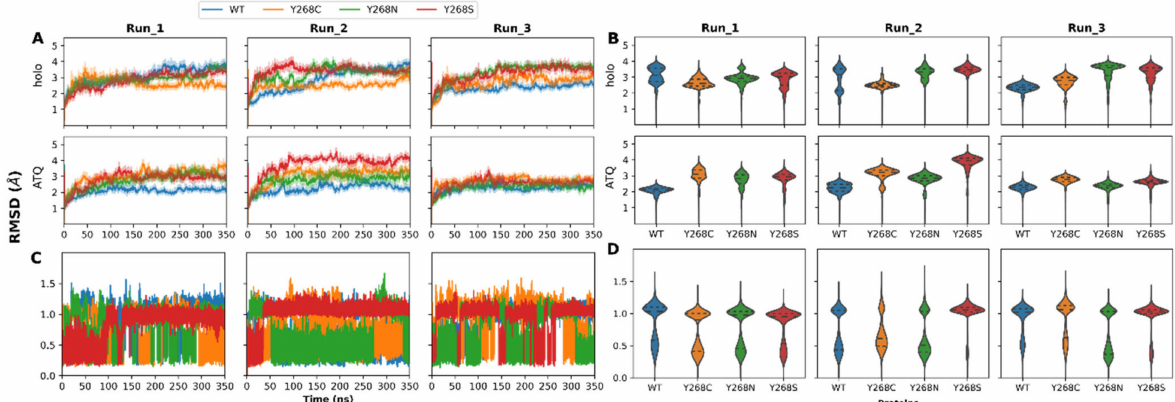
Figure 6. Molecular dynamics trajectory analysis of the changes to protein root mean square deviation (RMSD) both in the holo and ATQ bound systems. ( A ) Protein RMSDs over the 350 ns simulation; ( B ) Protein RMSD violin plot showing conformational distribution and sampling; ( C ) Ligand (ATQ drug) RMSD over the 350ns simulation; ( D ) ATQ RMSD violin plot presenting conformational sampling and